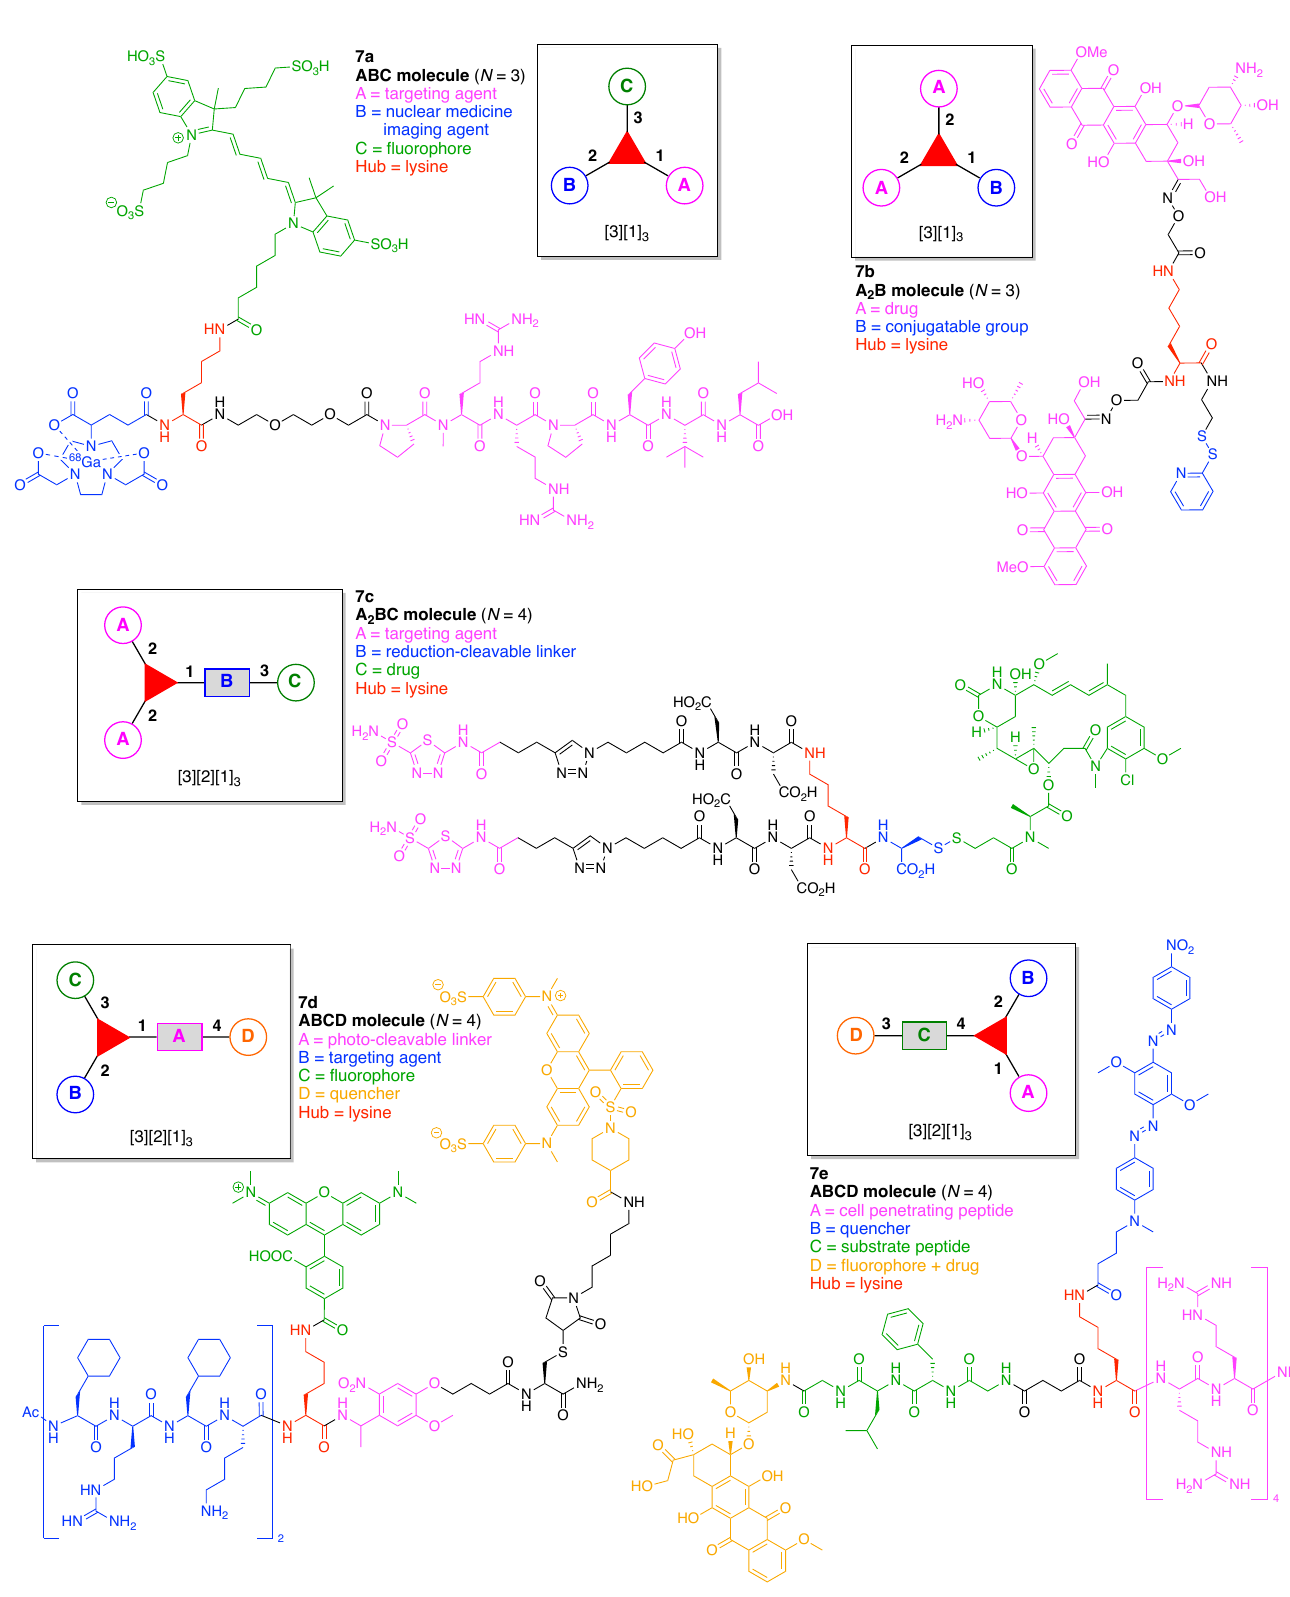
Figure 13. Five examples each with a single Lys hub. A FRET-based theranostic probe ( 7e ) was developed (Figure 13) [113]. The probe is comprised of a single Lys as a hub and four functional components: (A) Arg 8 as a cell penetrating peptide; (B) Black Hole Quencher-2 (BHQ-2); (C) the tetrapeptide GFLG,